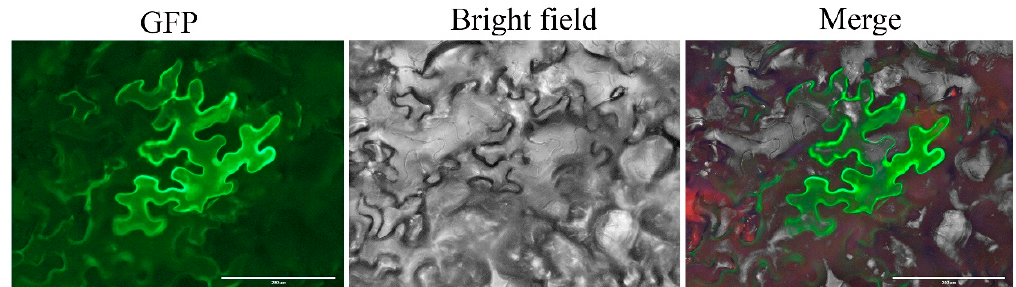
Figure 7. Subcellular localization of RsOFP2.3 . The left column shows the green fluorescent protein (GFP) signal; the middle column shows the bright field image, and the right column shows the merged image.